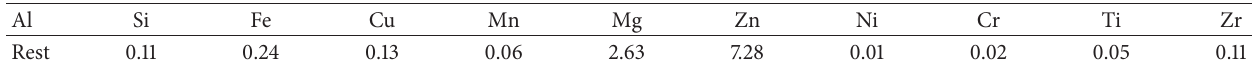
Figure 1: A simple schematic presentation of process steps in the hot stamping process chain. Table 1: Chemical composition (in